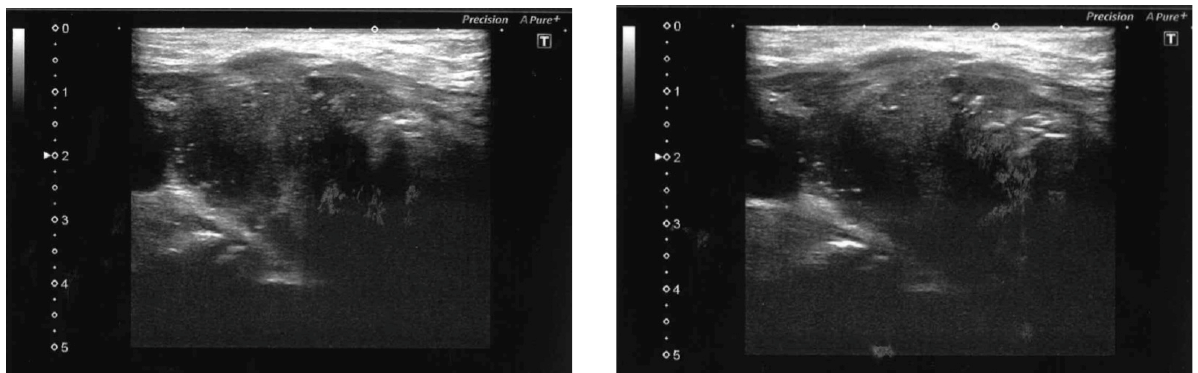
Figure 1. Heterogeneous appearance with diffuse microcalcifications on ultrasonography of the left thyroid lobe.